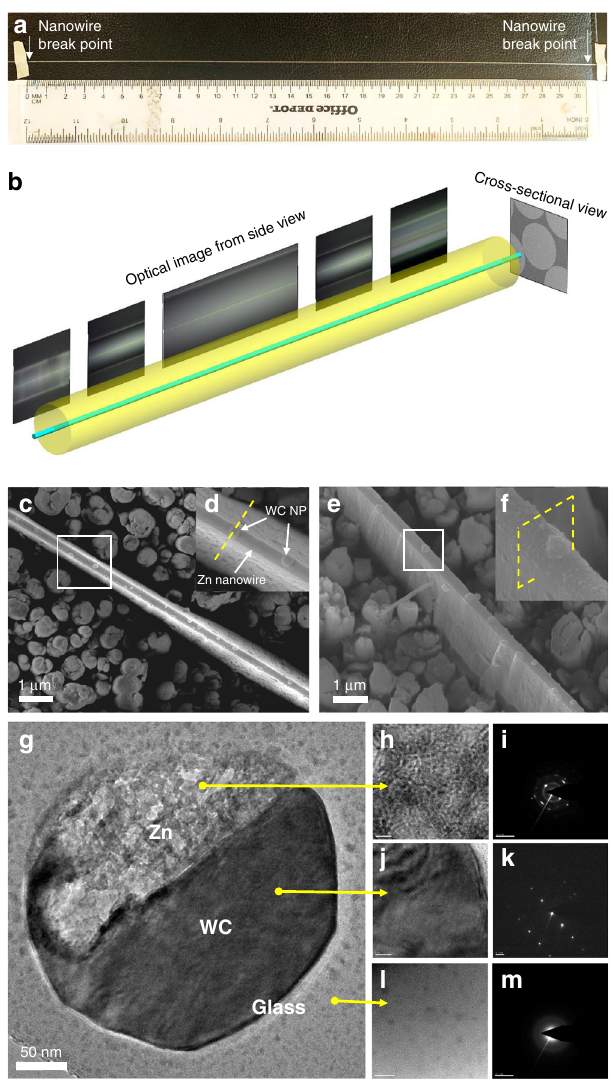
Fig. 3 Characterization of Zn-WC ultra fi ne/nanowires integrity. a 31-cm- long Zn-WC nanowire measured by a ruler. b Demonstration of the nanowire continuity characterization by optical microscope. SEM images of the top view ( c , d ) and isometric view ( e , f ) of Zn-WC nanocomposite nanowire after AOE deep etching. d , f are the corresponding magni fi ed images. g TEM characterization of the cross-sectional nanowire samples, as shown in d , f by the yellow dashed line. h , j , l are the TEM images of high magni fi cation for Zn and WC nanoparticles and surrounding borosilicate glass, respectively (scale bar 1 nm). i , k , m are the corresponding images of the diffraction pattern, indicating polycrystalline, single crystalline, and amorphous